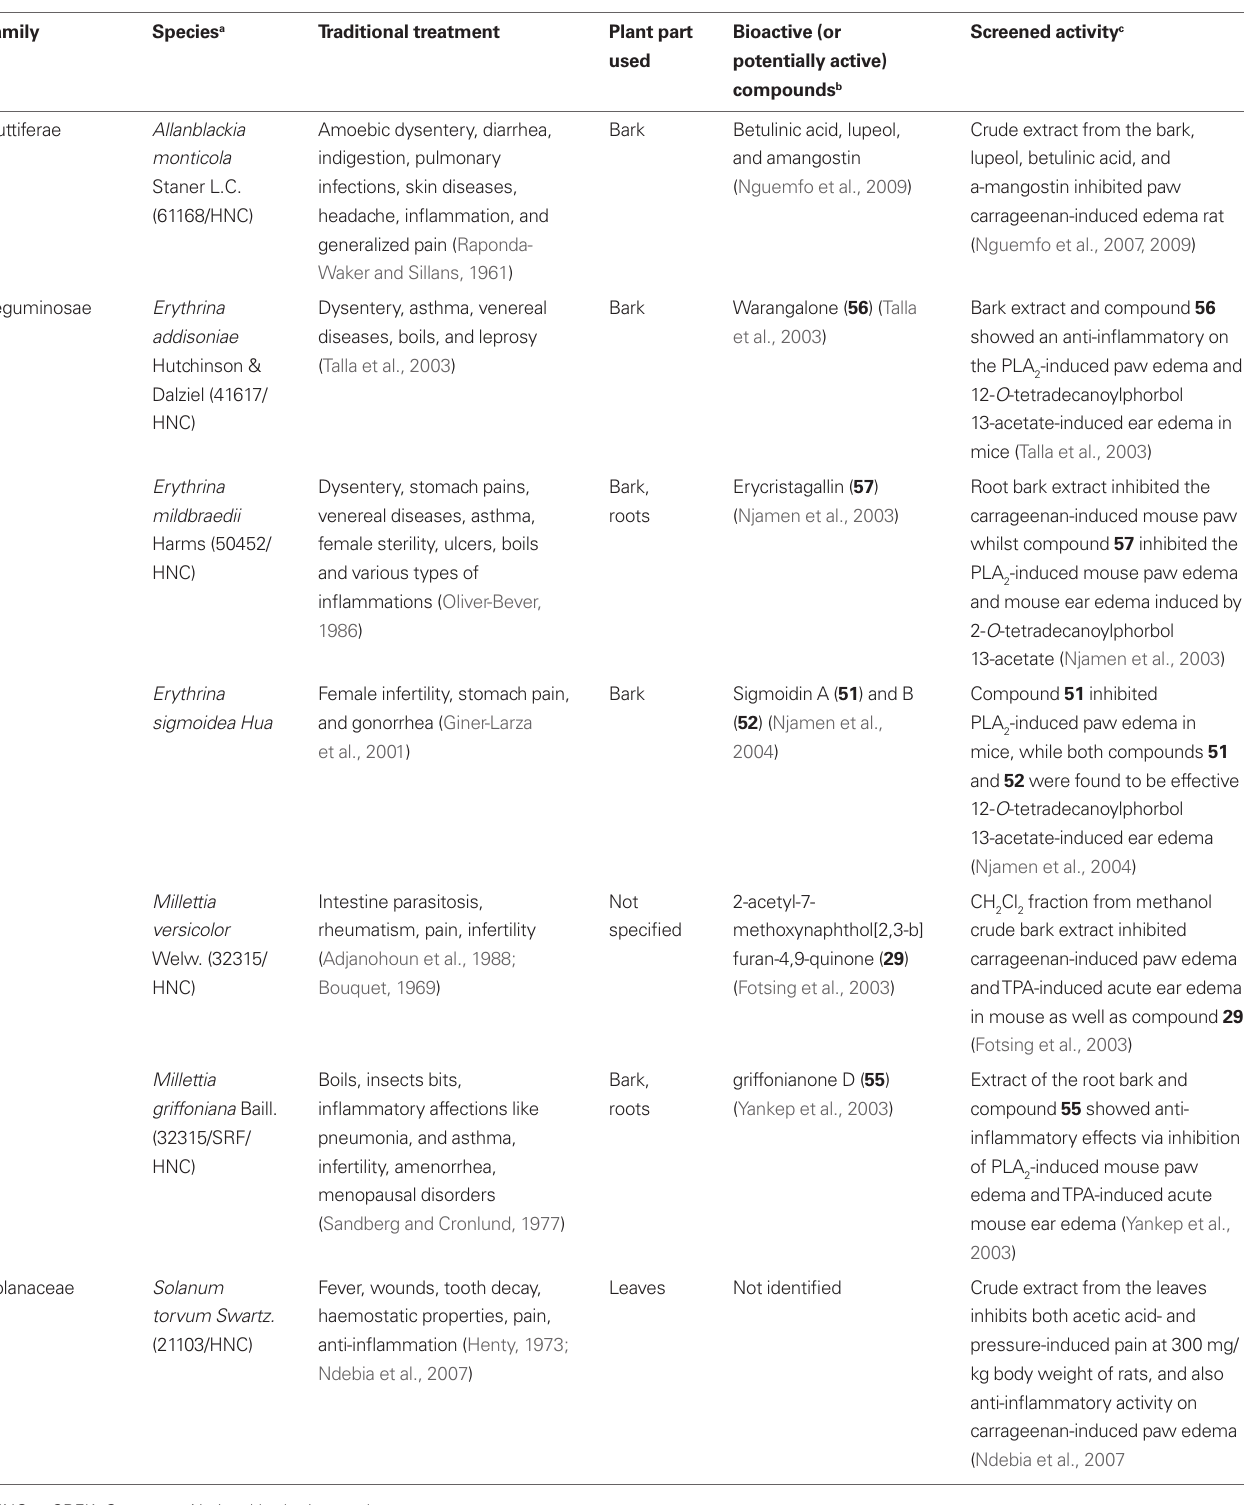
Table 4 | Plants used in Cameroon as anti-inflammatory and analgesic agents, with evidence of their activities.